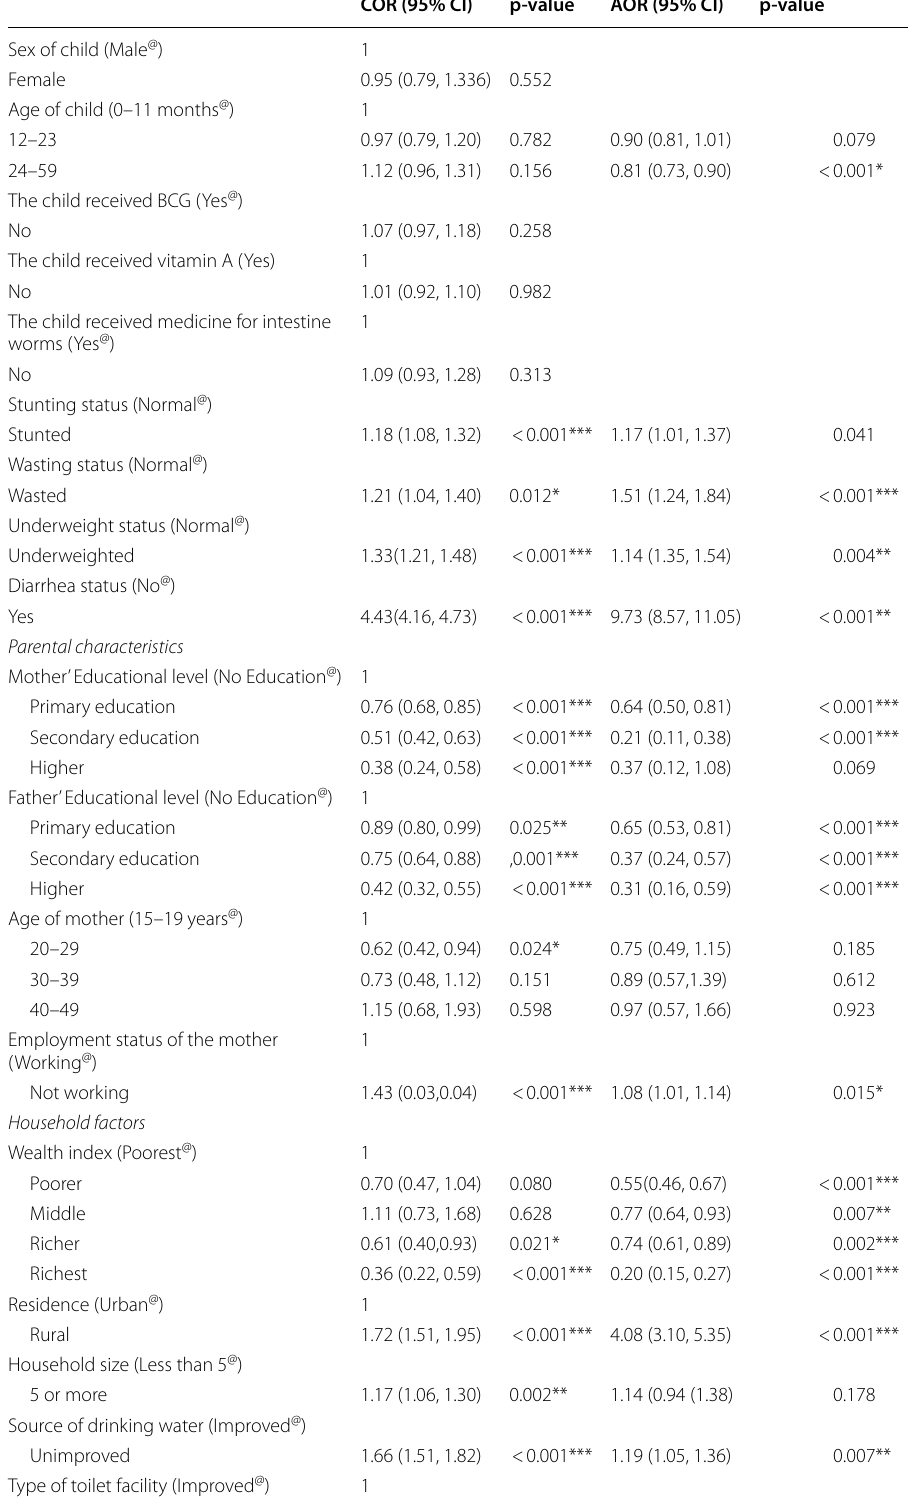
Table 2 Generalized multilevel mixed model parameter estimates of CIAF among under-five children in Ethiopia over time,